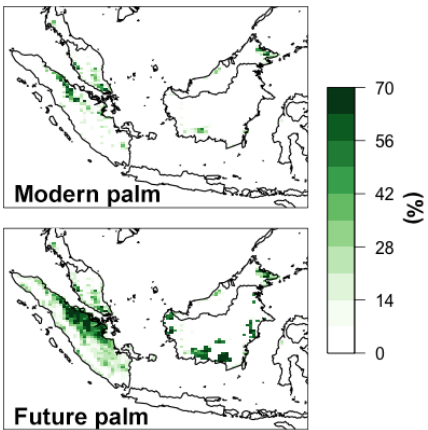
Figure 3. Percentage of vegetated area occupied by oil palm plan- tations for Modern (2010) and Future scenarios. Note that estimates for palm plantation increases from 2010 to the near-term future are only available for Sumatra and Kalimantan; palm plantation cover- age in other regions are assumed